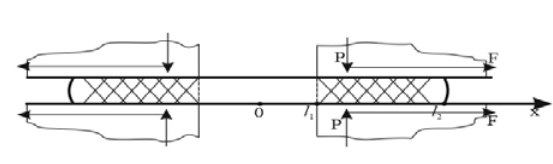
Fig.1. On the problem of complex plate